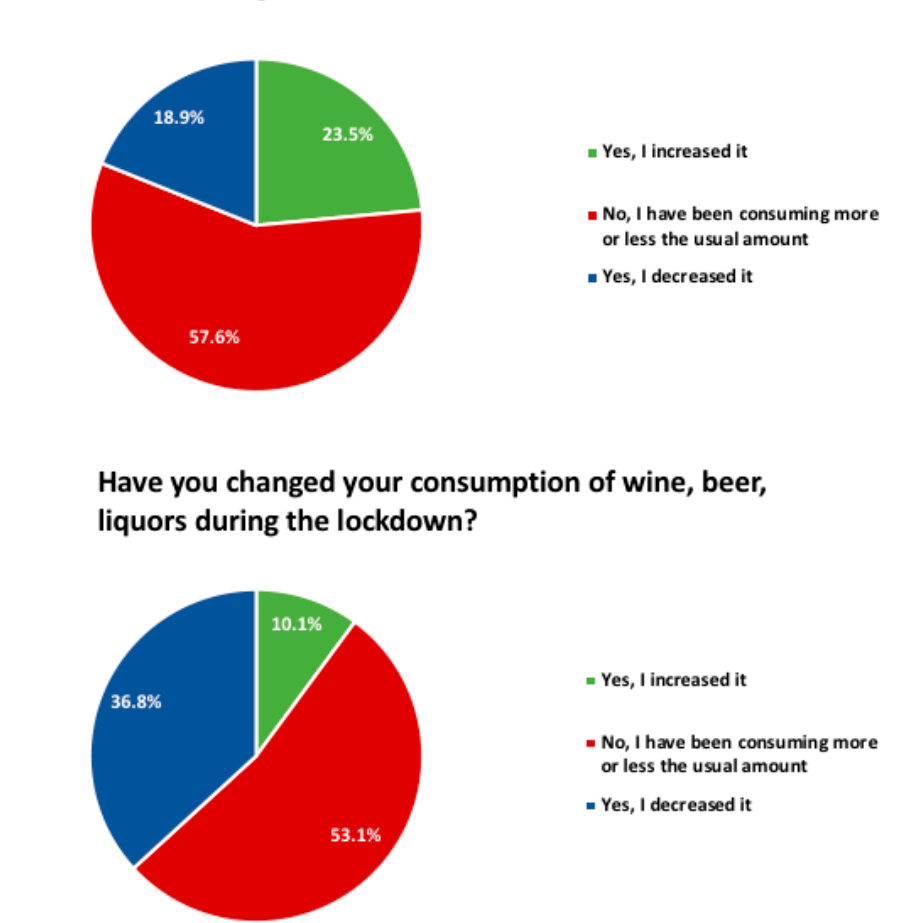
Figure 2. Reported changes in comfort food and alcohol consumption during the lockdown.